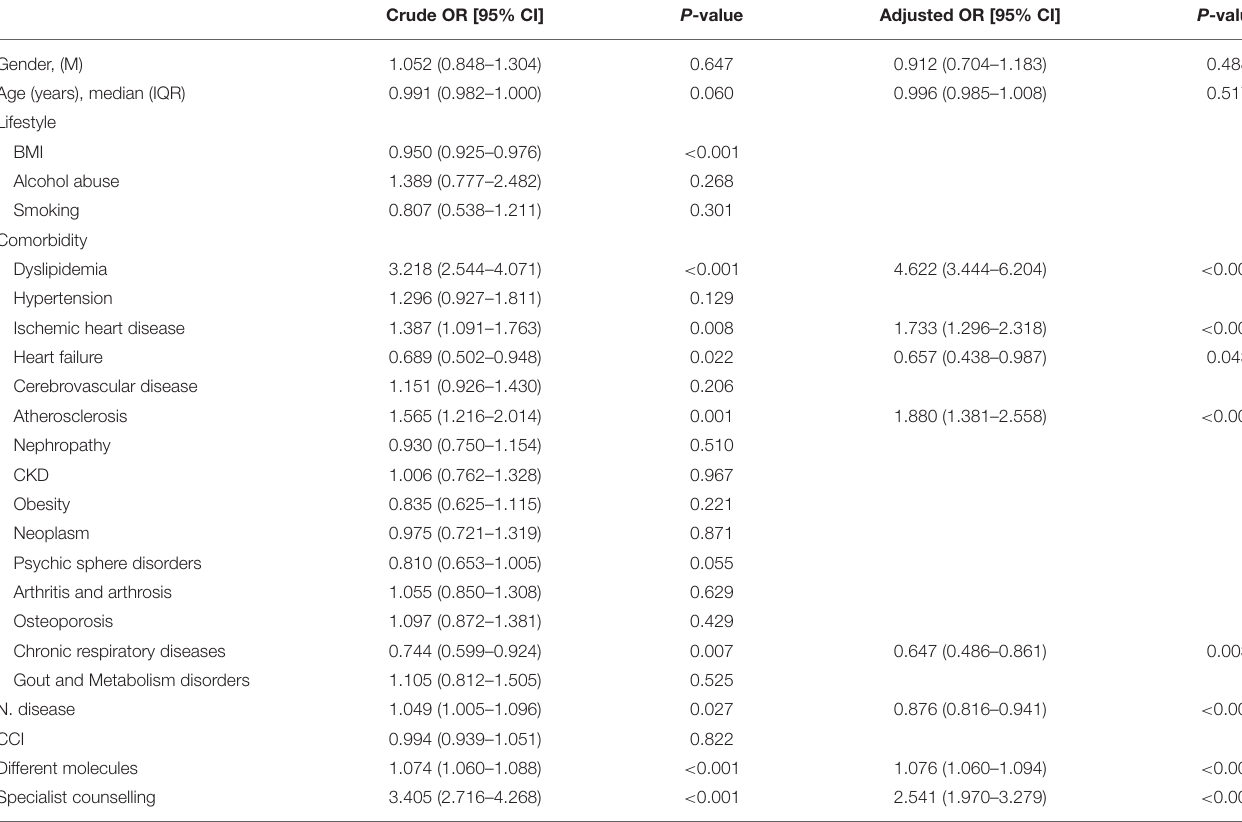
TABLE 2 | Probability of being treated with lipid-lowering drugs (LLDs) in the patients with diabetes. Crude OR [95% CI] P -value